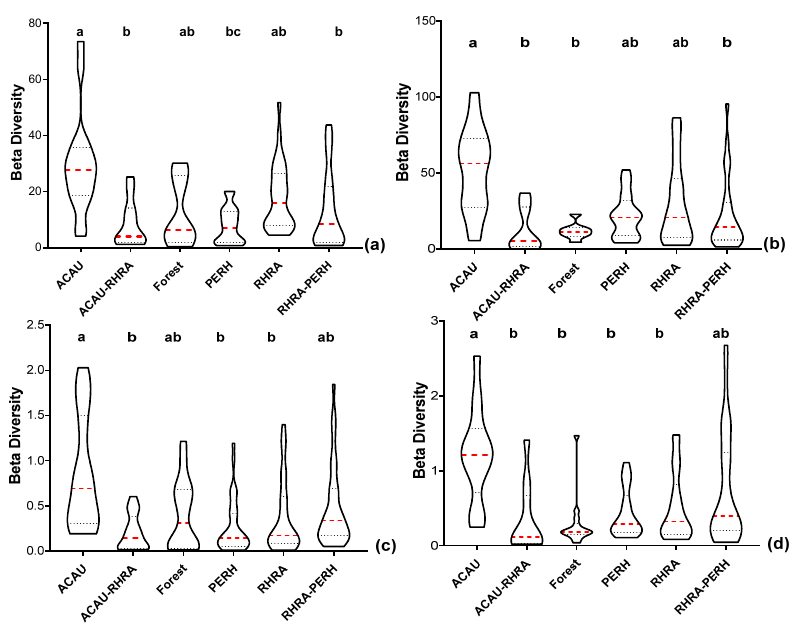
Figure 17. Violin plots showing the 10th and 90th percentiles range of spectral β diversity for five predominant mangrove species (ACAU, ACAU–RHRA, PERH, RHRA, and RHRA–PERH) and a forest class for ( a ) VNIR spectral reflectance at the 2.5 m native spatial resolution. ( b ) SWIR spectral reflectance at the 2.5 m native spatial resolution, ( c ) VNIR spectral reflectance resampled to the same spatial resolution (25 m) as MIG/ME, ( d ) SWIR spectral reflectance resampled to the same spatial resolution (25 m) as MIG/ME. Red dashed lines represent median and the dotted lines represent the quartiles. Different superscripts letter indicates statistically significant ( p < 0.05) differences between pairs of predominant mangrove species classes.